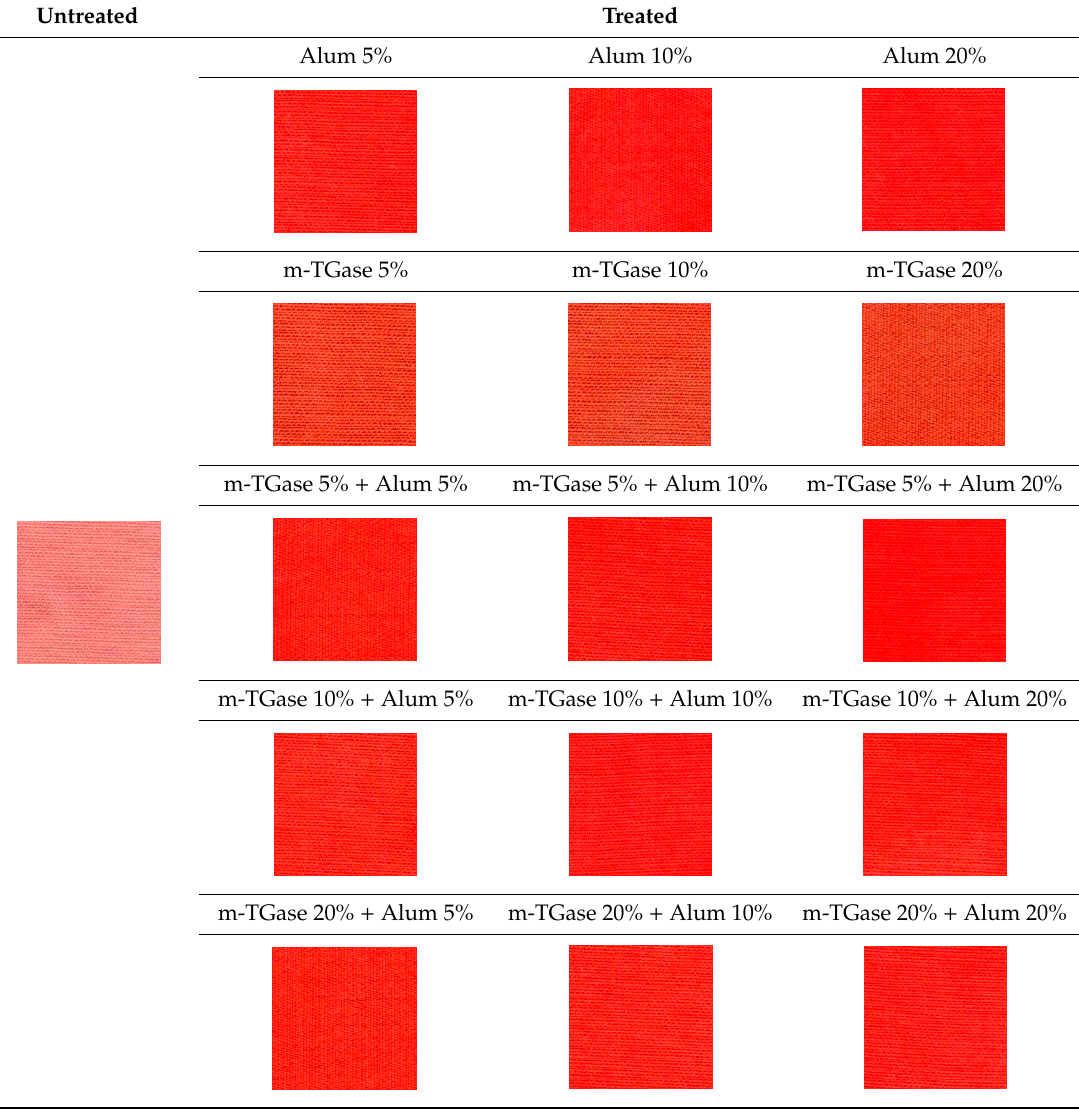
Table 2. Color of dyed wool (treated and untreated).